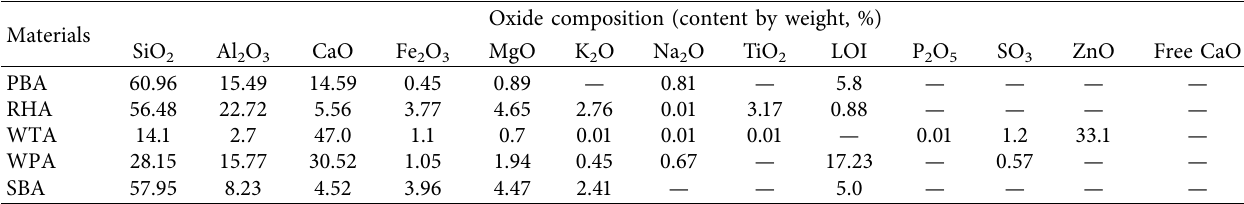
Table 7: Chemical oxide composition of the additive materials [15, 17, 27–30].